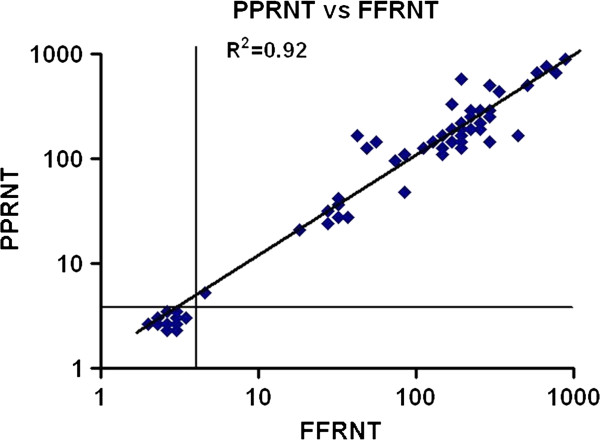
Correlation of the mean neutralizing titers of 69 serum samples determined by FFRNT and PPRNT. Based on the distribution, a positive cut-off value of 1:4 was defined for PPRNT and FFRNT. The solid line indicates complete correlation.